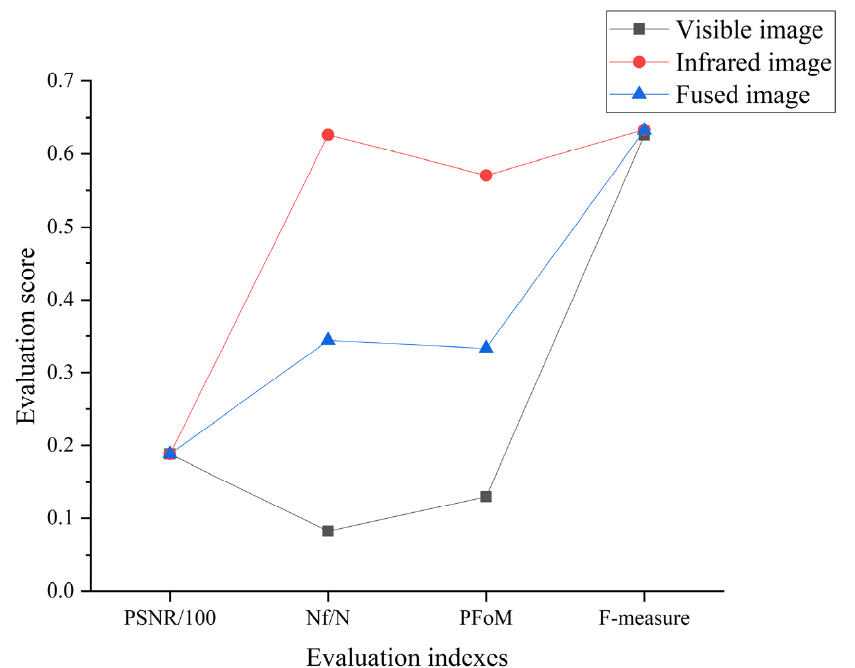
Figure 10. The four evaluation indexes of the improved method for three images.